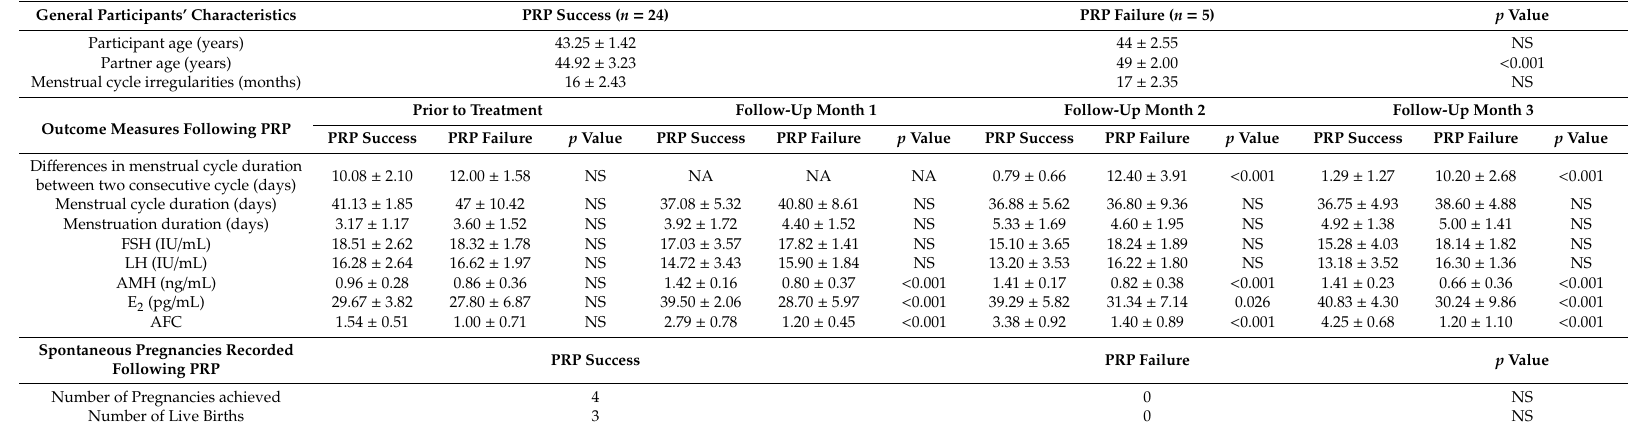
Table 4. Statistical analysis and outcome assessment prior and following PRP intraovarian infusion regarding the Perimenopausal pilot study. General Participants’